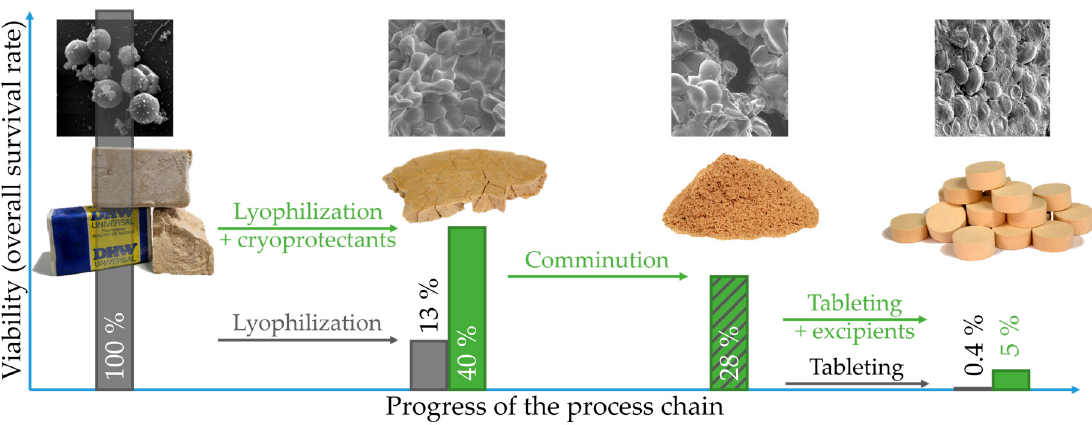
Figure 1. Process chain overview and process step specific influence on survival of Saccharomyces cerevisiae cells. Green color highlights increase of survival rate by addition of cryoprotectants and excipients. Cryoprotectants-containing lyophilizate was comminuted. Percentage values describe mean